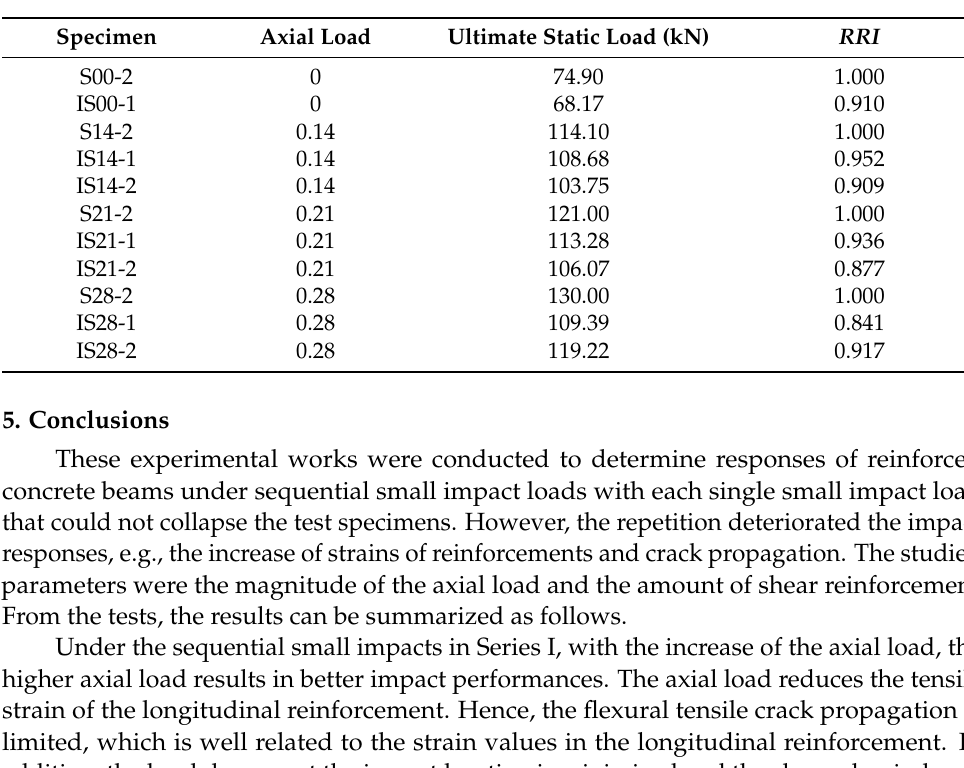
Table 3. Ultimate static capacity and Residual Resistance Index ( RRI